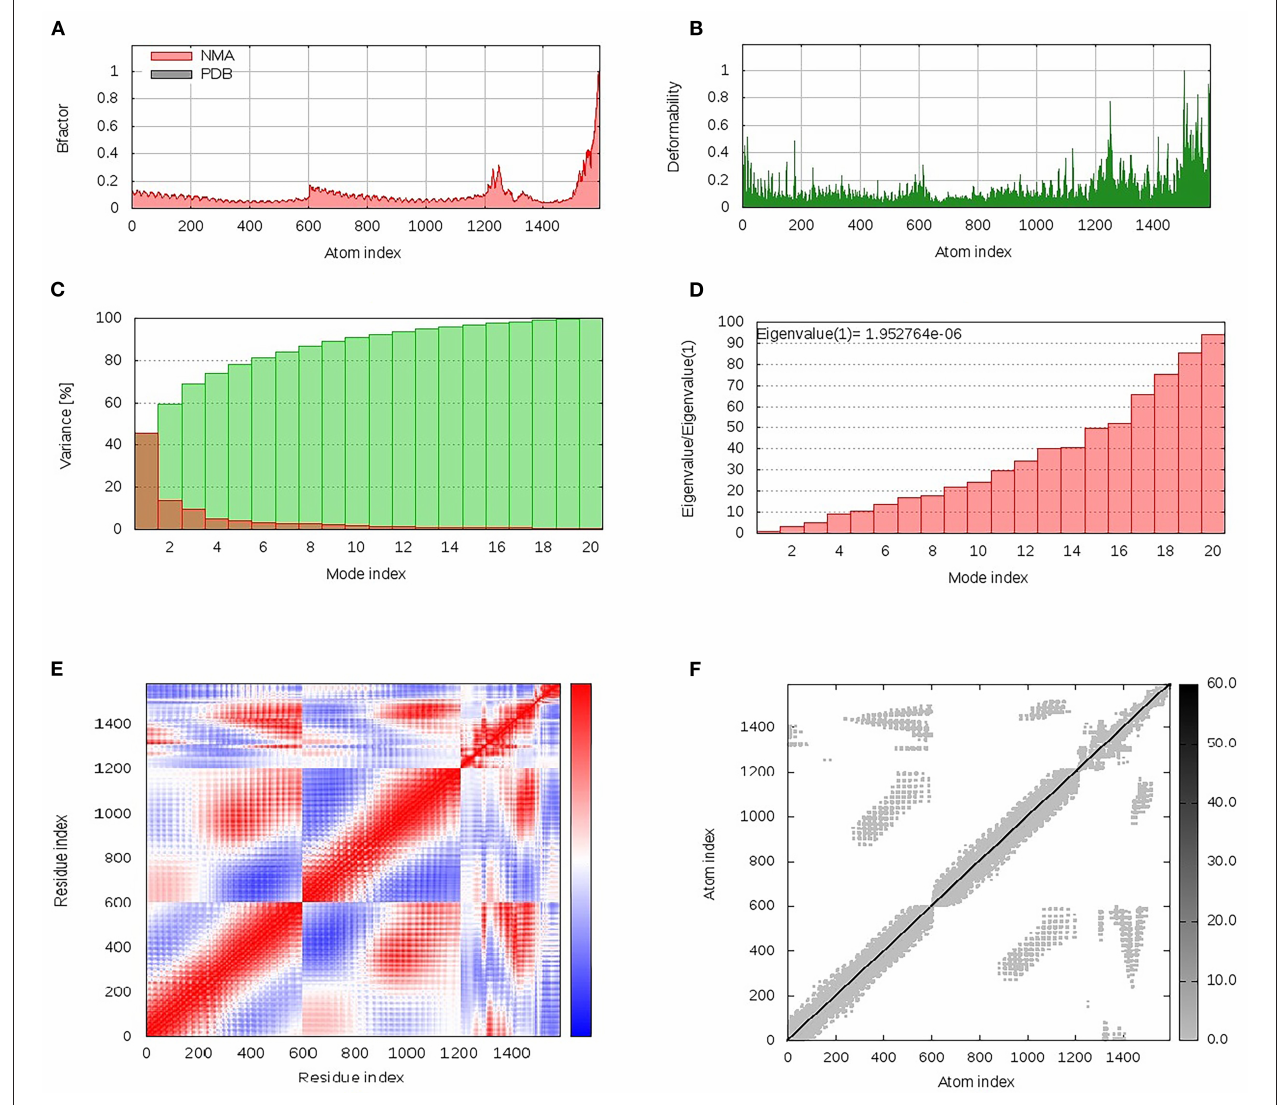
FIGURE 6 | Dihedral coordinate-based normal-mode analyses of multitope vaccine- h TLR-4 complex; ligand-receptor interaction was assessed throughout comparative (A) B-factor indices, (B) deformabilities, (C) variance, (D) eigenvalues, (E) covariance of residue indices, and (F) elastic network analysis.